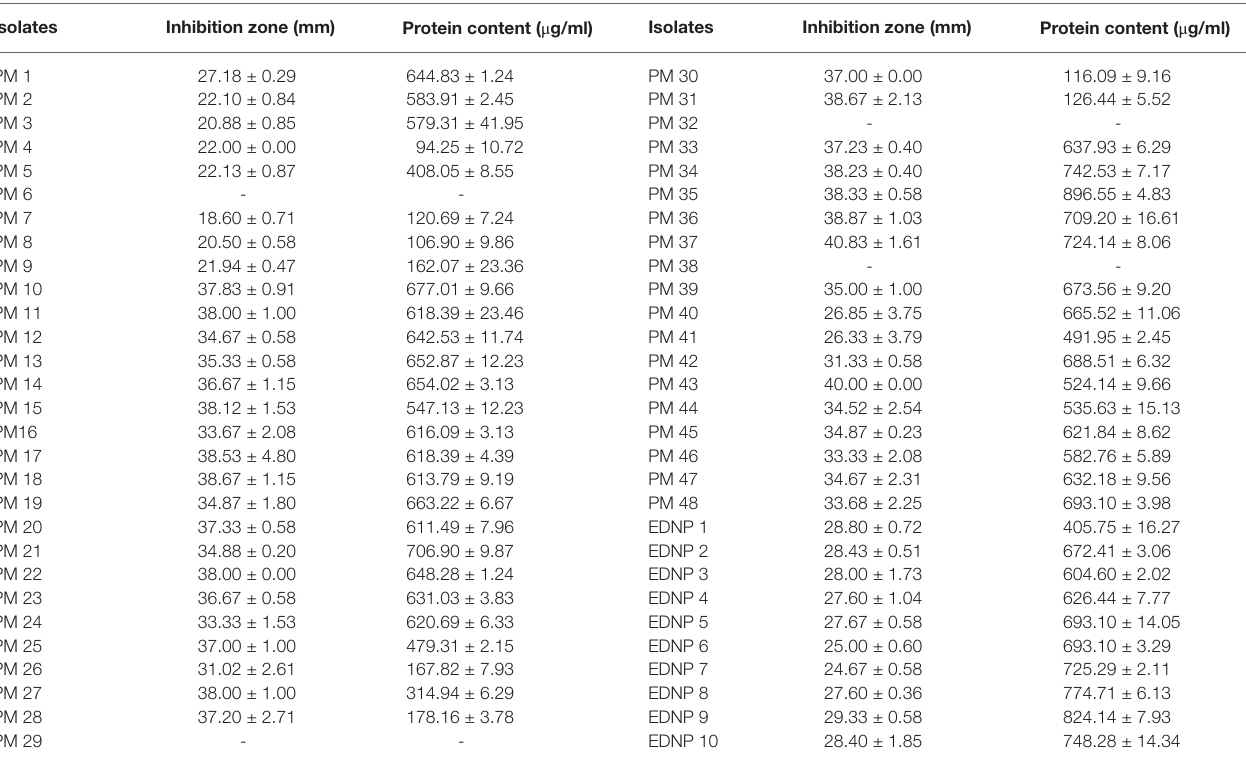
The mean with SD of three replications was used to represent the